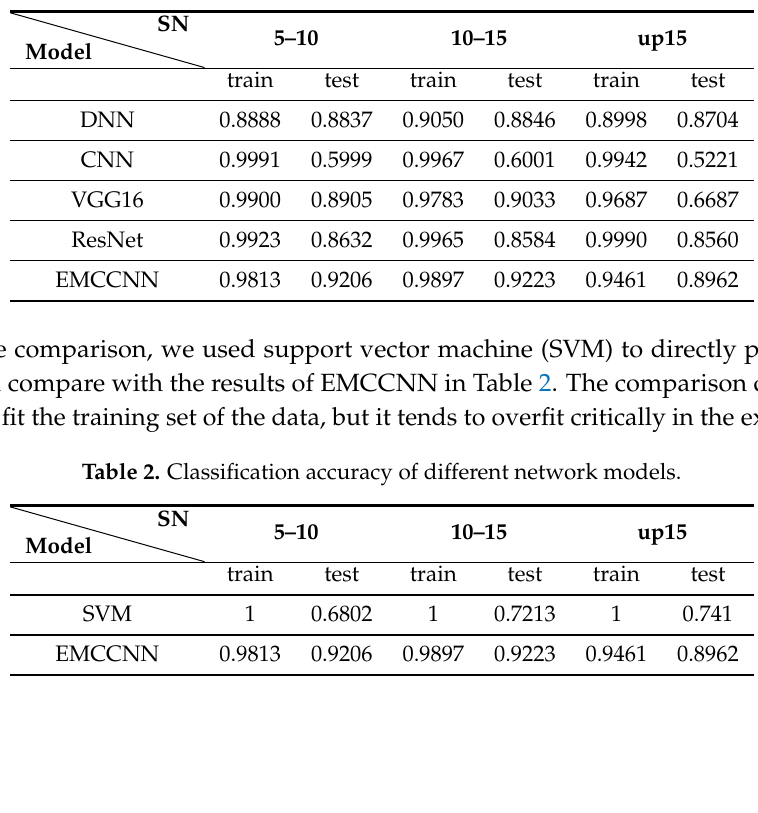
Table 1. 1D classification accuracy of different network models.